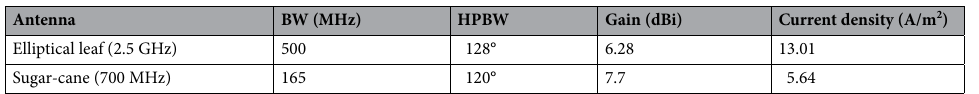
Antenna Elliptical leaf (2.5